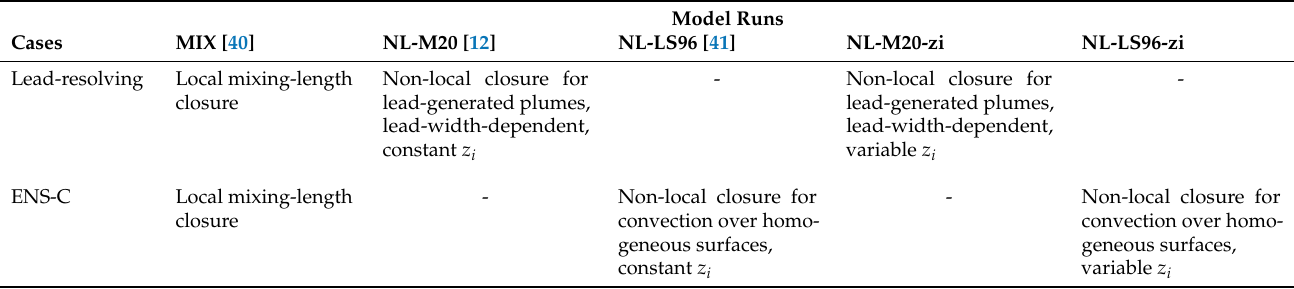
Table 1. Overview of the model runs and the corresponding turbulence closures used in this study for the lead-resolving cases (ENS-1km, ENS-2km, ENS-5km-d20km, ENS-5km-d40km, and ENS-10km) and for the case ENS-C with the same fractional sea ice concentration in each grid cell (see Figure 2 for the